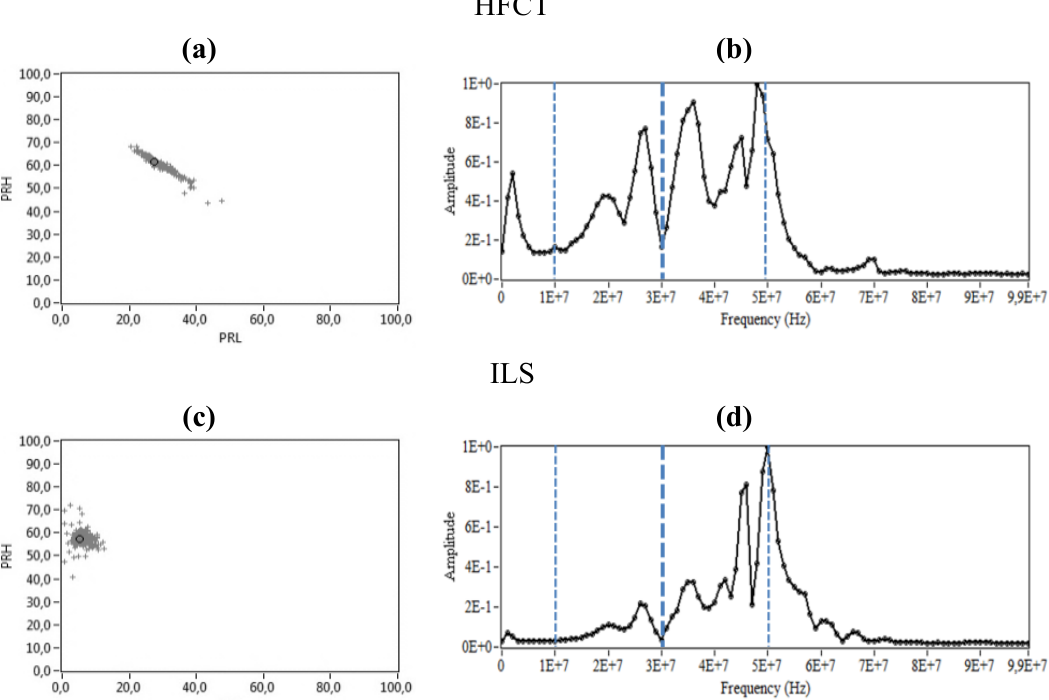
Figure 11. Surface PD. ( a ) PR map of the signals measured with the HFCT, ( b ) Normalized average spectral power of the signals measured with the HFCT, ( c ) PR map of the signals measured with the ILS, ( d ) Normalized average spectral power of the signals measured with the